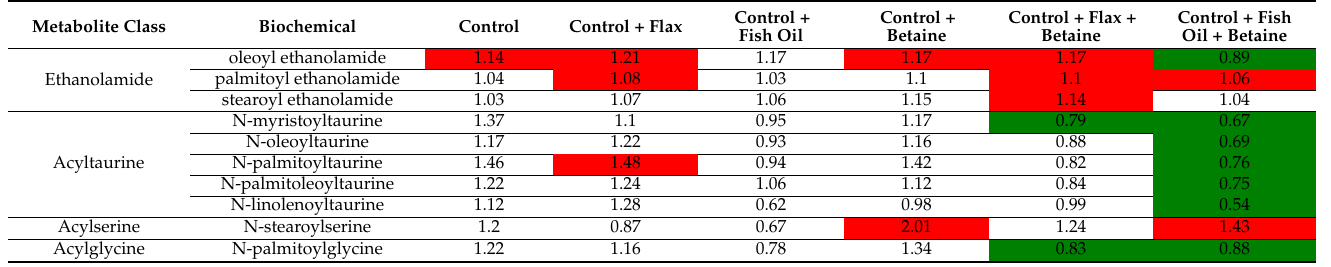
Table 11. Endocannabinoids and N-acylated amino acids which changed during the study while consuming control, or betaine, flax, and fish oil supplemented foods *.